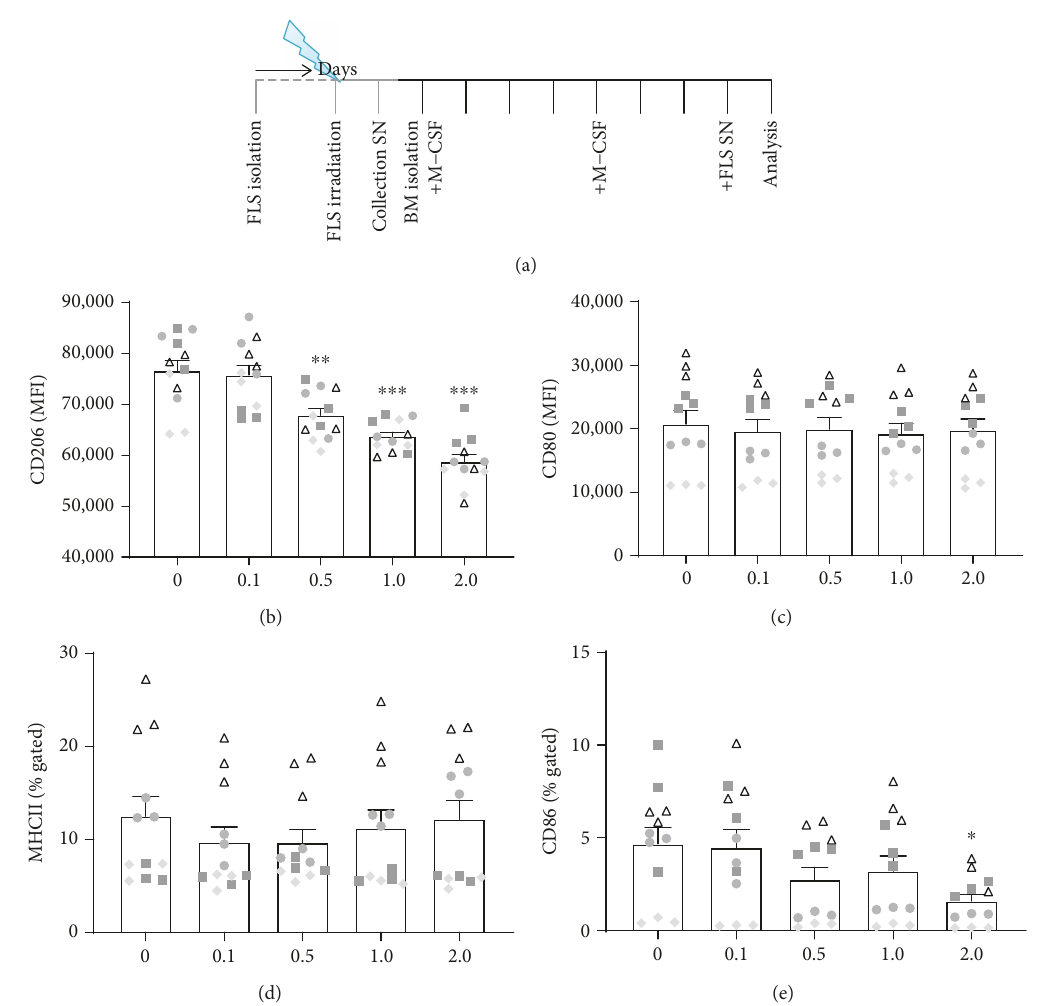
Figure 3: Conditioned supernatants of irradiated fi broblast-like synoviocytes have an impact on the expression of phenotype characteristic surface markers of macrophages in dependence of the radiation dose. h TNF- α tg bone marrow cells were isolated and di ff erentiated into M0 macrophages according to the experimental set-up shown in (a). Prior to macrophage generation, fi broblast-like synoviocyte cultures (FLS) were generated, phenotyped, and irradiated. Conditioned SN were collected and stored at -80 ° C until they were added to macrophage cultures 24h prior to characterization of the macrophage phenotype. The M2 marker CD206 (b) was signi fi cantly reduced at doses starting from 0.5Gy while M1 markers CD80 (c), MHCII (d), and CD86 (e) showed fewer alterations. While CD80 expression was not in fl uenced by LD-RT, MHCII showed a slight reduction at 0.1 and 0.5Gy, respectively. CD86 expression was signi fi cantly reduced at 2.0 Gy and already slightly downregulated at 0.5 and 1.0Gy. Depicted is data from four independent experiments, each performed in triplicate (data points from one experiment are marked with equal symbols). Data is presented as the mean ± SEM. ∗ p < 0 05 , ∗∗ p < 0 01 , and ∗∗∗ p < 0 001 . Representative histograms of the analyses are displayed in Supplementary Figure